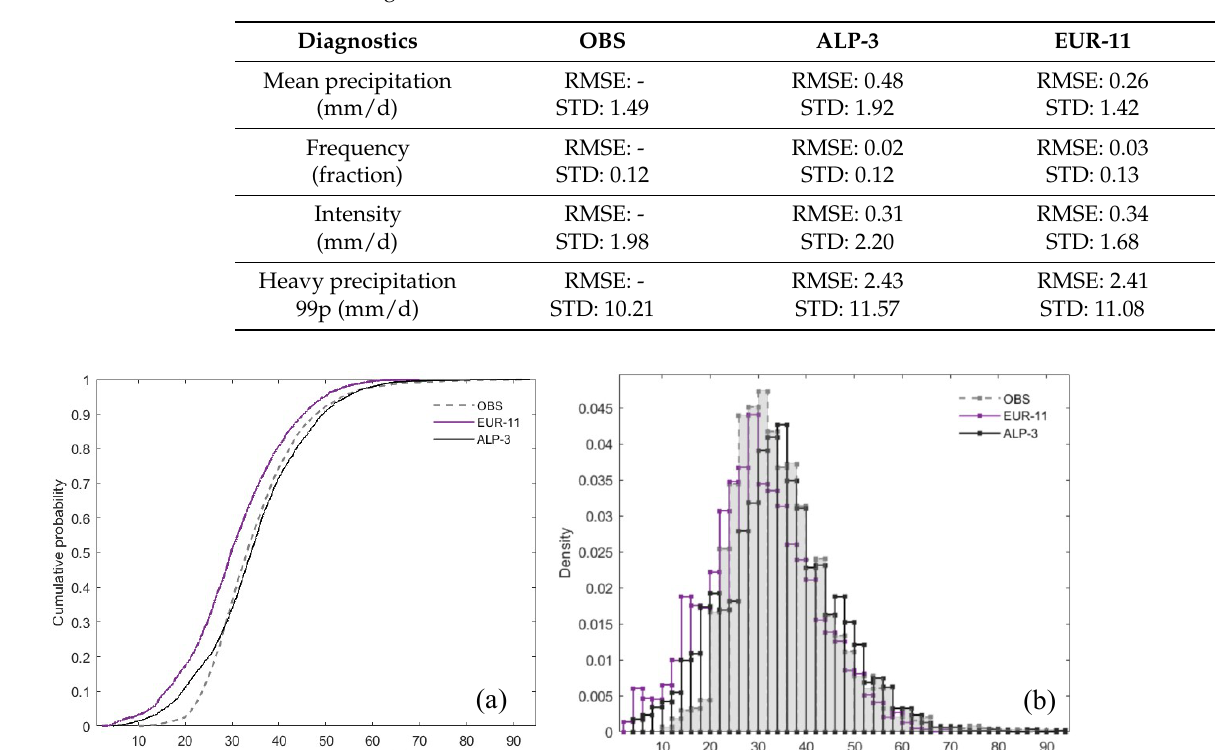
Table 3. Root mean square error (RMSE) and standard deviation (STD) referred to the daily statistical indicators in Figure 2.